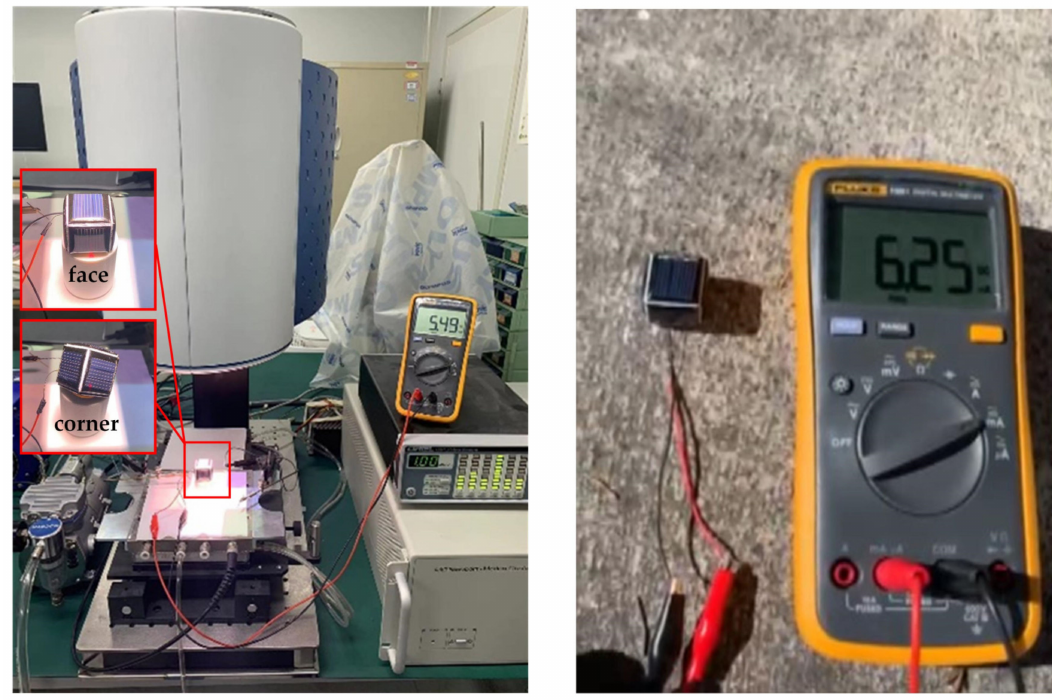
Figure 7. Self-power performance testing under simulated and natural sunlight.